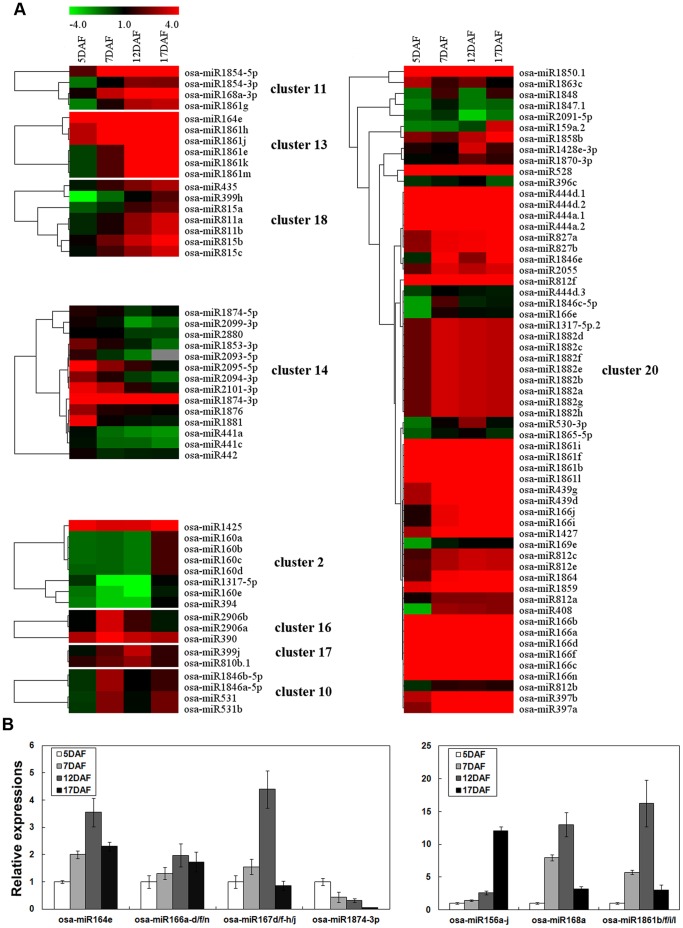
Differential expression analysis of known miRNAs.(A) Heatmap for clustering analysis of the differentially expressed known miRNAs. The bar represents the scale of the expression levels of the miRNAs (log 2). (B) Validation via quantitative real-time RT-PCR of differentially expressed miRNAs obtained from deep sequencing. U6 snRNA was used as a reference, and the expression levels of each of the miRNAs were then compared with the expression at 5 DAF, which was set to 1.0. Error bars indicate the standard deviation (±SD) of three replicates.